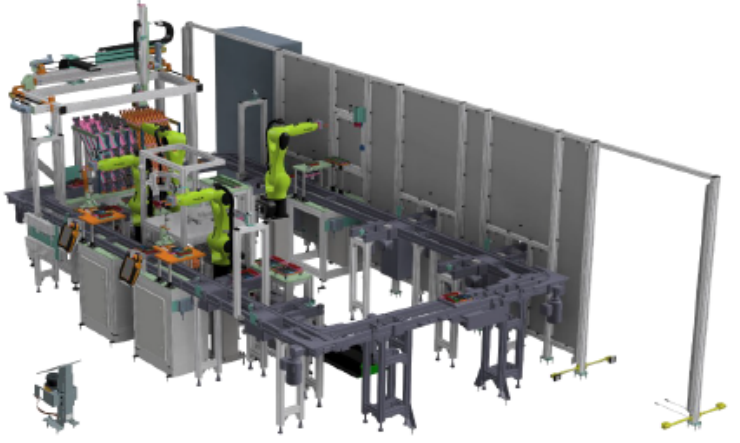
Figure 5. Three-dimensional model of the SmartFactory production